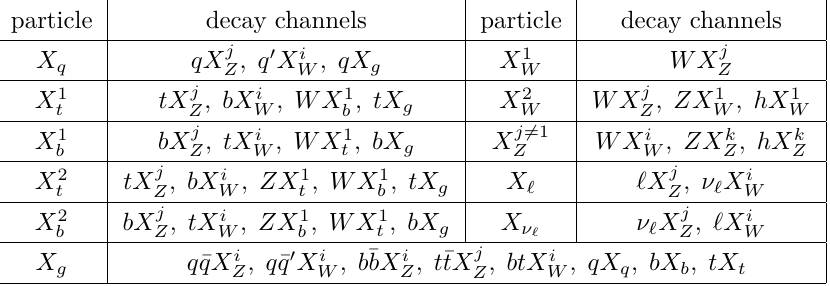
Table 1 . The 20 BSM states and their decay channels considered for constructing proto-models in this